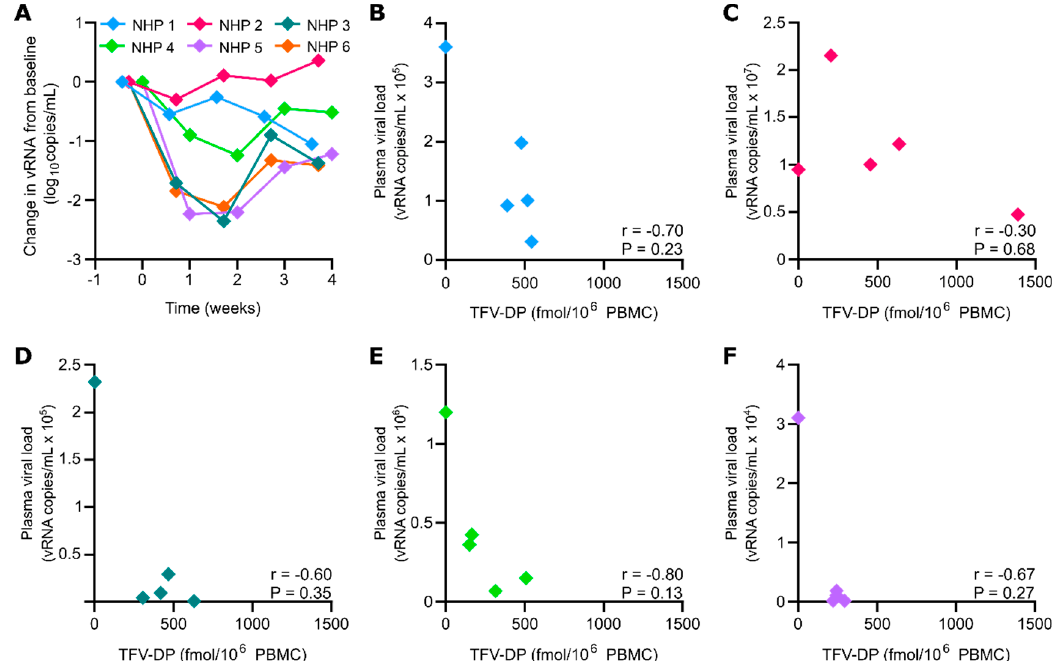
Figure 3. Viral load reduction and correlation with TFV-DP PBMC concentration. ( A ) Viral load reduction from baseline of nTAF t ( n = 6). Change in SHIV RNA from baseline (log 10 copies/mL) at week 1, 2, 3 and 4 throughout continuous subcutaneous TAF dosing. Data are presented for each individual NHP. ( B ) NHP 1 TFV-DP PBMC concentration correlation with plasma viral load. ( C ) NHP 2 TFV-DP PBMC concentration correlation with plasma viral load. ( D ) NHP 3 TFV-DP PBMC concentration correlation with plasma viral load. ( E ) NHP 4 TFV-DP PBMC concentration correlation with plasma viral load. ( F ) NHP 5 TFV-DP PBMC concentration correlation with plasma viral load. Statistical analysis on panels ( B – F ) performed by Spearman correlation.